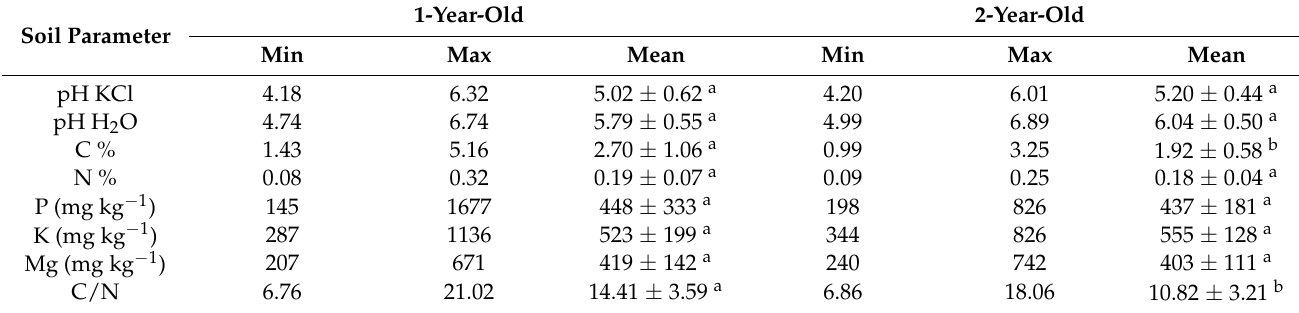
Table 1. Soil parameters for the examined bare-root nursery beds with 1- and 2-year-old